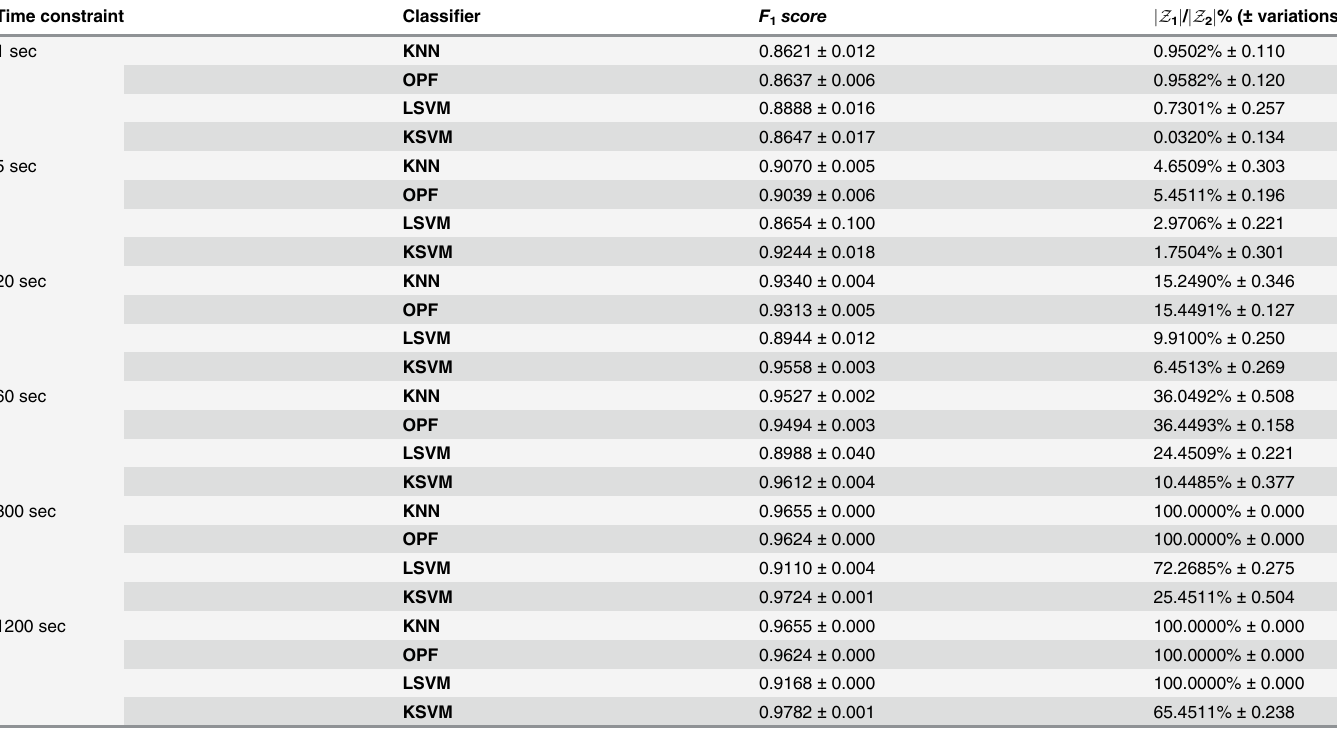
Table 10. IJCNN dataset: Predictivity performance over Z 3 and final training set size, j Z 1 j as a percentual of j Z 2 j , for each classification model and learning time constraint using random